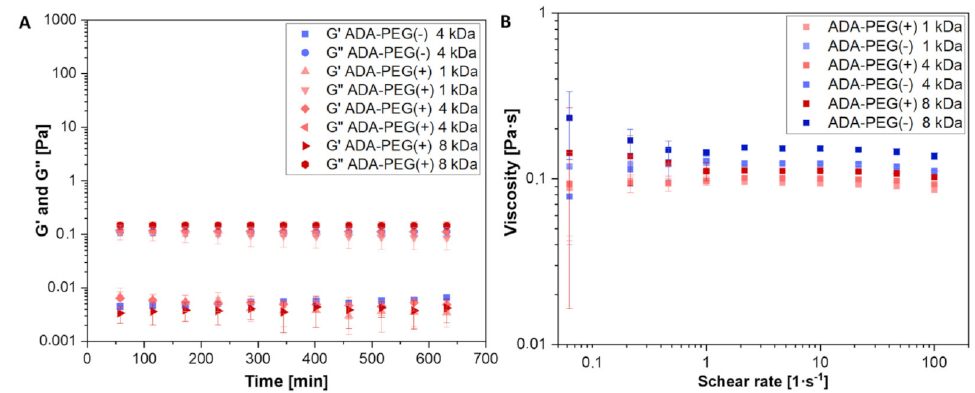
Figure 3. ( A ) Oscillatory time-sweep study for the measurement of G (cid:48)(cid:48) (above) and G (cid:48) (below) of ADA-PEG(+) and ADA-PEG(-) inks under constant shear rates at 37 ◦ C; ( B ) continuous flow sweep for measuring viscosity of ADA-PEG(+) and ADA-PEG(-) inks for a flow sweep up to 100 s − 1 ( n =